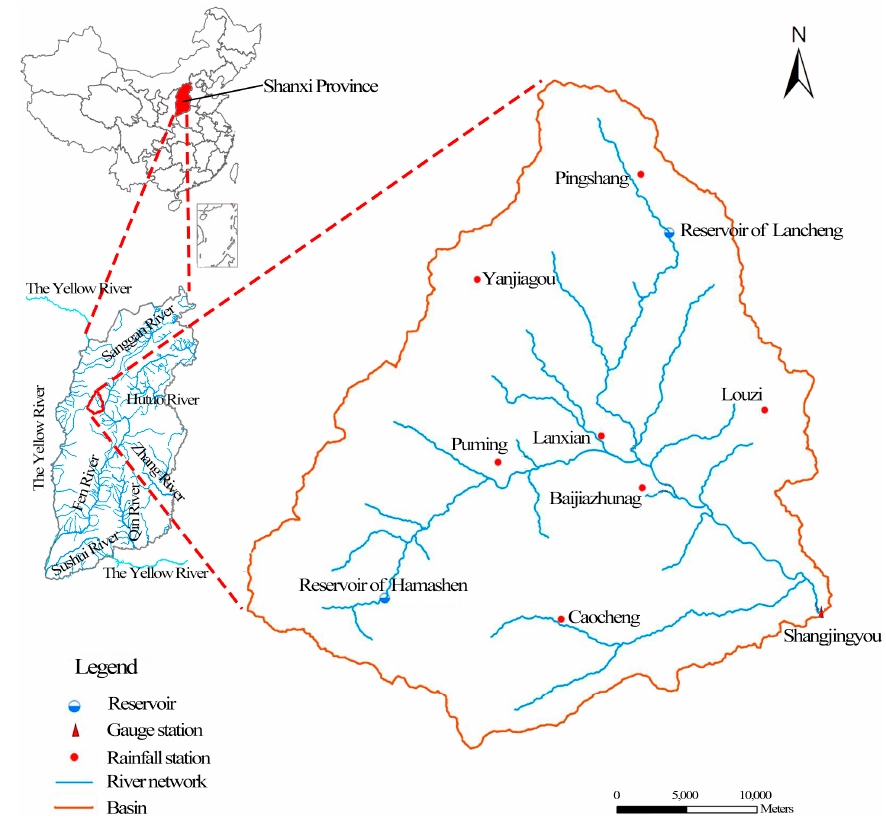
Figure 1. Location, rainfall, and gauging stations of the Lanhe Watershed.